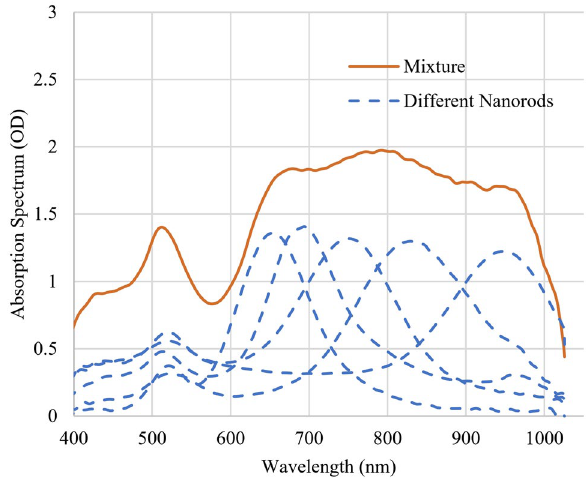
Figure 2. Absorption spectra of different nanorods. The dashed spectra with absorption peaks at 650, 700, 750, 808, and 950 nm are of gold nanorods with the average aspect ratios of 2.4, 2.9, 3.5, 4.1, and 5.5, respectively. The solid line represents the absorption spectrum of the mixture of the five different nanorods with the average aspect ratios from 2.4 to